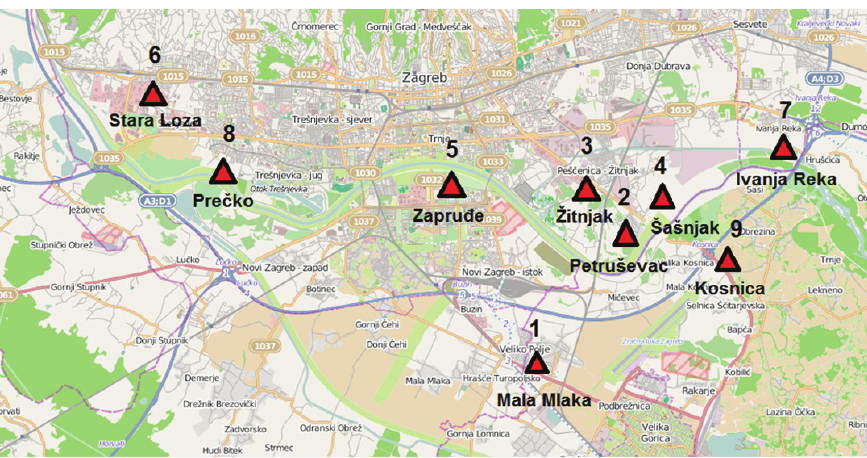
FIGURE 3. Locations of polluted water supply wells in the city of Zagreb (1. High and constant concentrations of atrazine, chromium, lead, cadmium and copper; 2. High concentrations of manganese; 3. High and constant concentrations of organic solvents; 4. High manganese concentrations; 5. Periodically high concentrations of lead; 6. High concentrations of lead, iron, manganese and trichloroethane solvent; 7. Higher concentration of nitrates, lead and organic solvents; 8. Excess of bacteria, cadmium and lead; 9. High concentrations of iron, manganese, zinc, lead and mercury)